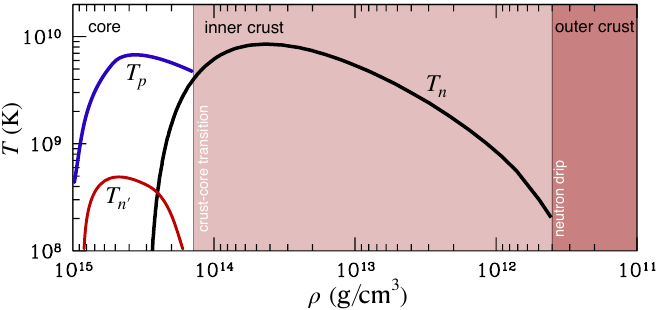
Figure 1. A sketch of the critical temperatures for superfluidity/superconductivity as a function of density. The indicated critical temperatures T n (black), T n (cid:48) (red), and T p (blue) represent neutron singlet, neutron triplet, and proton singlet pairing, respectively. The least “secure” of these critical curves is that for neutron triplet pairing. The edges of the coloured regions indicate the boundaries between the core and the inner crust (at just above half the nuclear saturation density) as well as the inner and outer crusts (at neutron drip; ρ ≈ 4 × 10 11 gcm − 3 ). The main message is that superfluid aspects come into play already at a temperature close to 10 10 K (about 1 MeV), very early in a neutron star’s life. The results provide a phenomenological representation of actual gap calculations within the BCS approximation, see [6] for